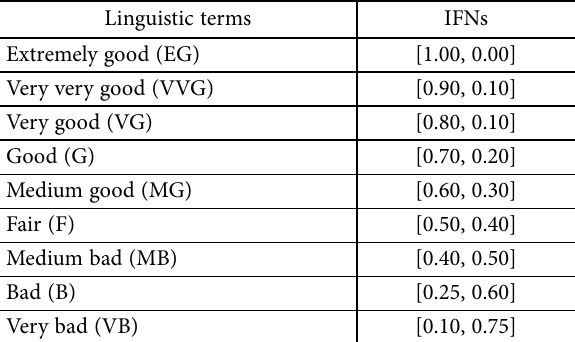
Table 4. Linguistic terms for alternative evaluation